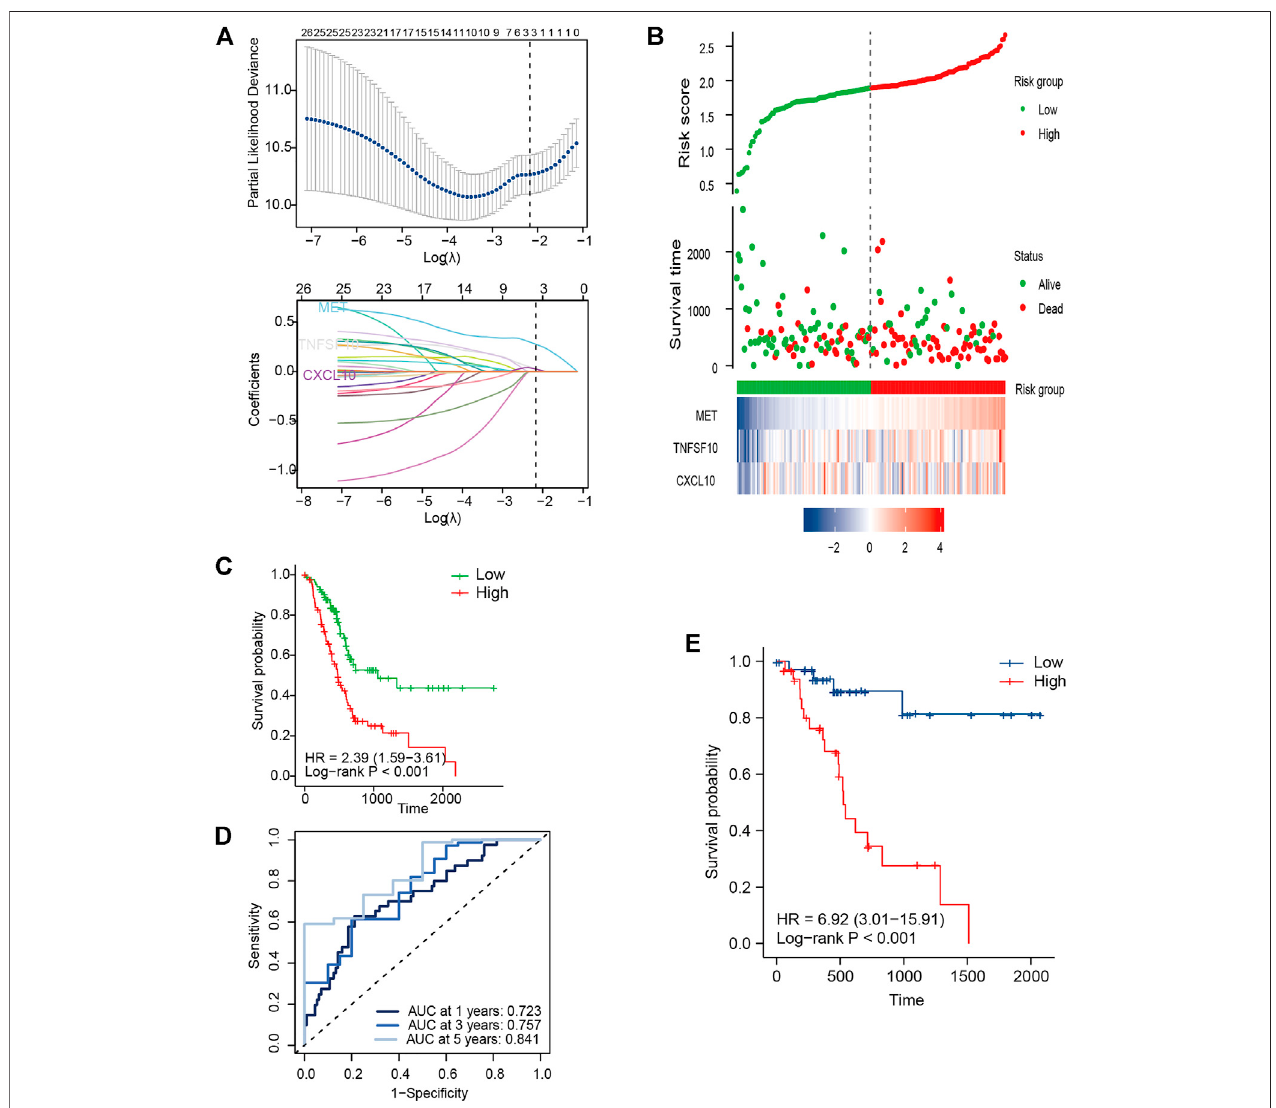
(D) ROC curve analysis of the IRGS for OS. (E) KM survival curves for DFS for PC